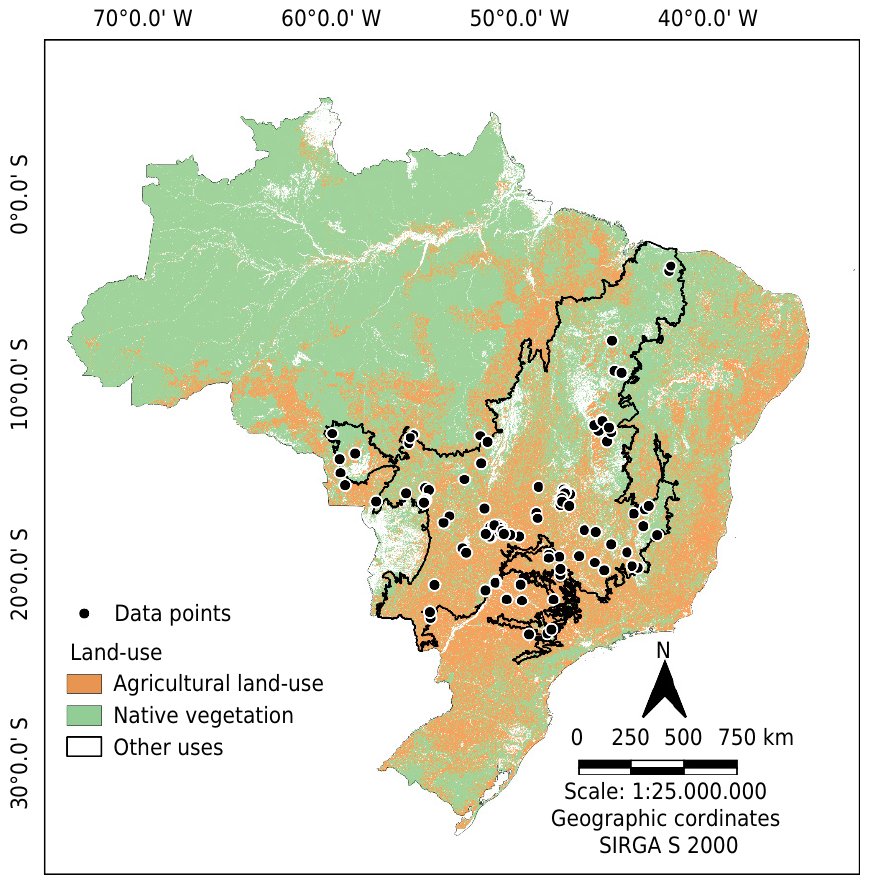
Figure 1. Study sites from peer-reviewed publications evaluating the rates of soil C stock change in agricultural areas under climate-smart soil management across Brazilian